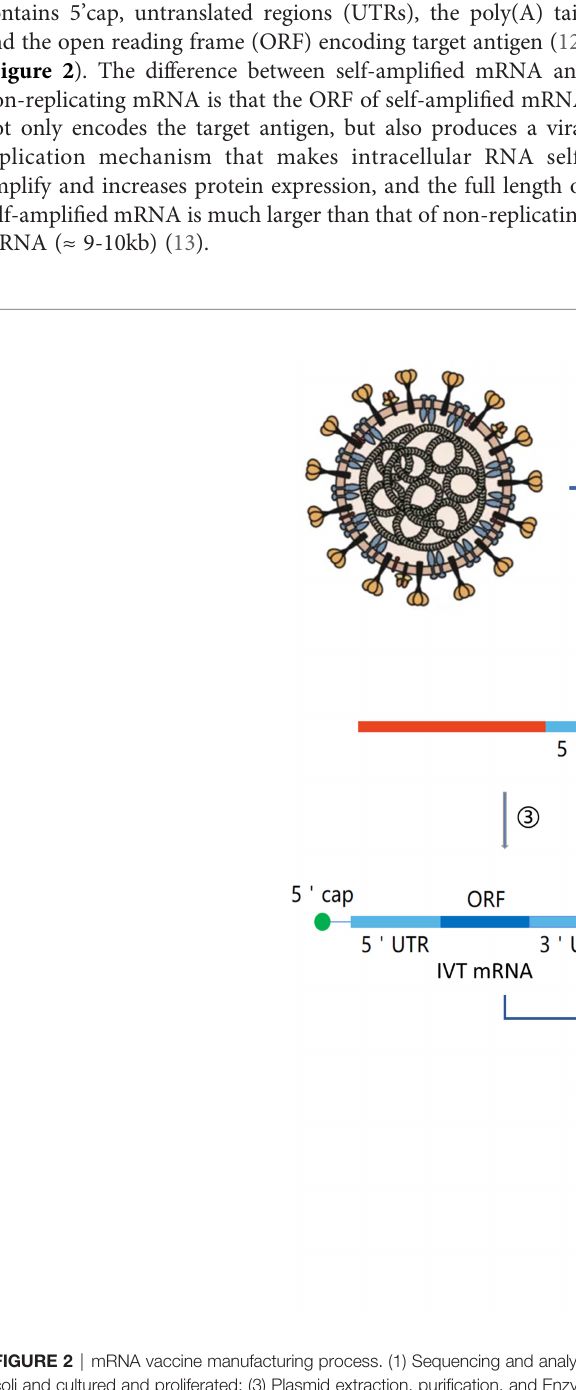
FIGURE 2 | mRNA vaccine manufacturing process. (1) Sequencing and analysis of essential proteins of the virus; (2) The introduction of the plasmid into Escherichia coli and cultured and proliferated; (3) Plasmid extraction, puri fi cation, and Enzymatic digestion; (4) in vitro transcription of mRNA; (5) Micro fl uidic mixing; (6) The process of encapsulating mRNA into lipid nanoparticles